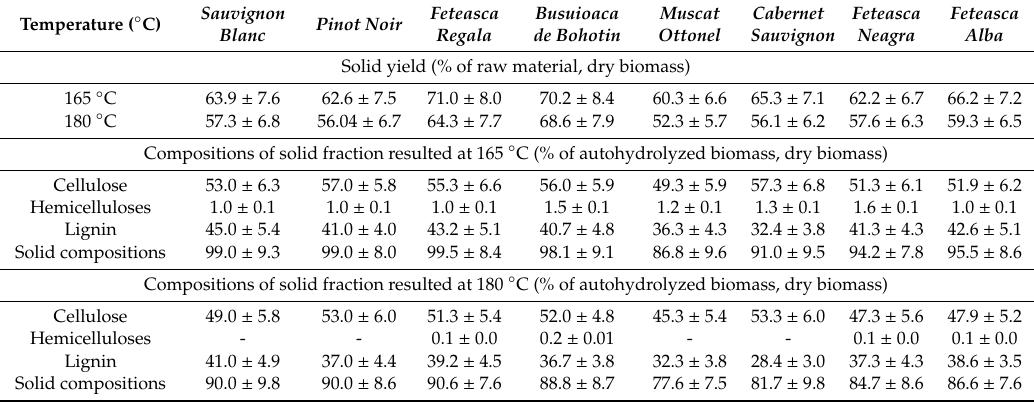
Table 1. Chemical compositions of vine-shoots waste and solid yield and chemical compositions of autohydrolysed vine-shoot waste obtained at 165 ◦ C and 180 ◦ C.